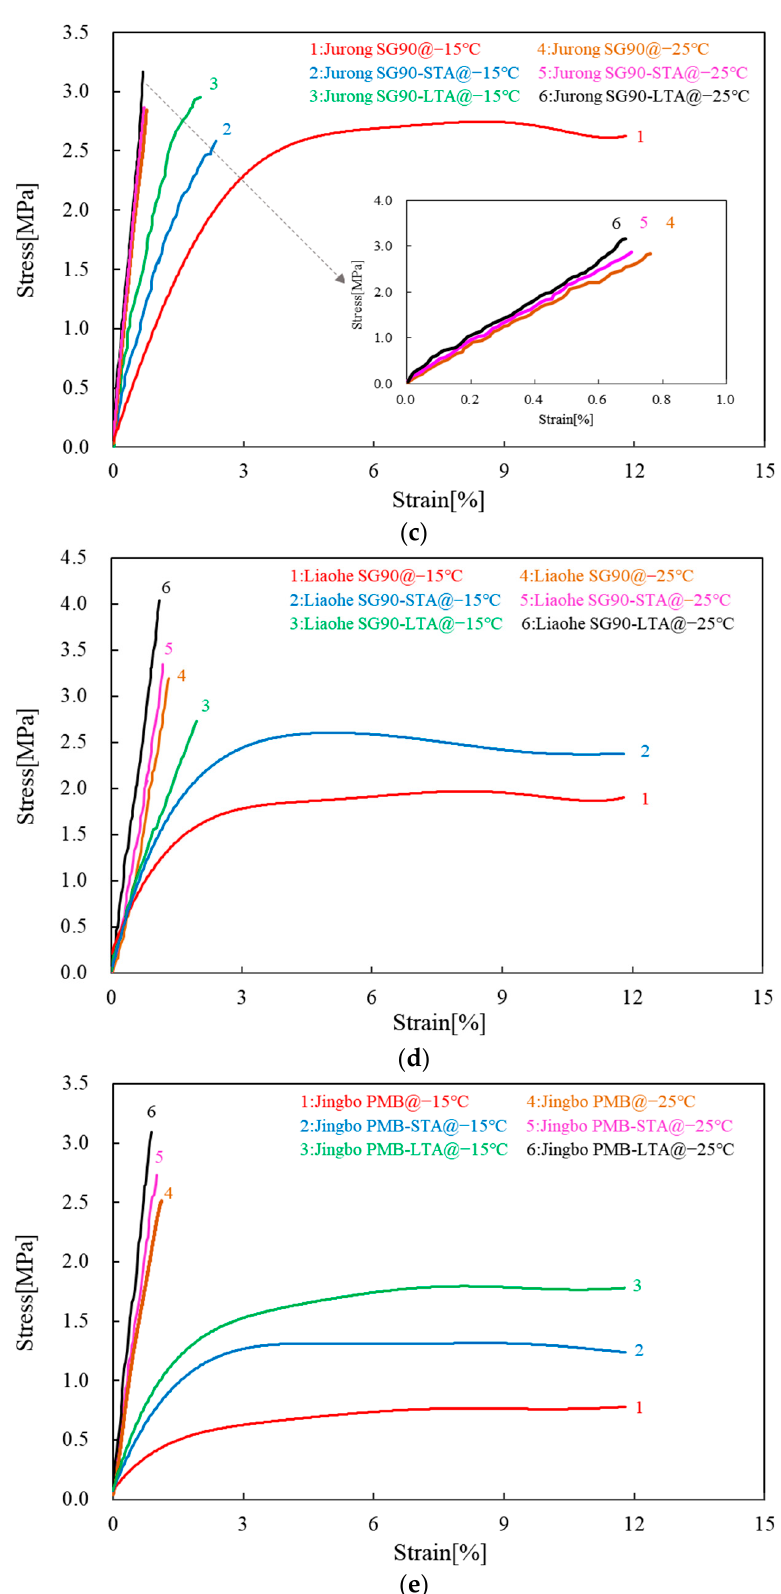
Figure 7. Tensile stress-strain curves of unaged, short-, and long-term aged bitumen binders: ( a ) Karamay SG70 bitumen; ( b ) Jingbo SG70 bitumen; ( c ) Jurong SG90 bitumen; ( d ) Liaohe SG90 bitumen; ( e ) Jingbo PMB bitumen.